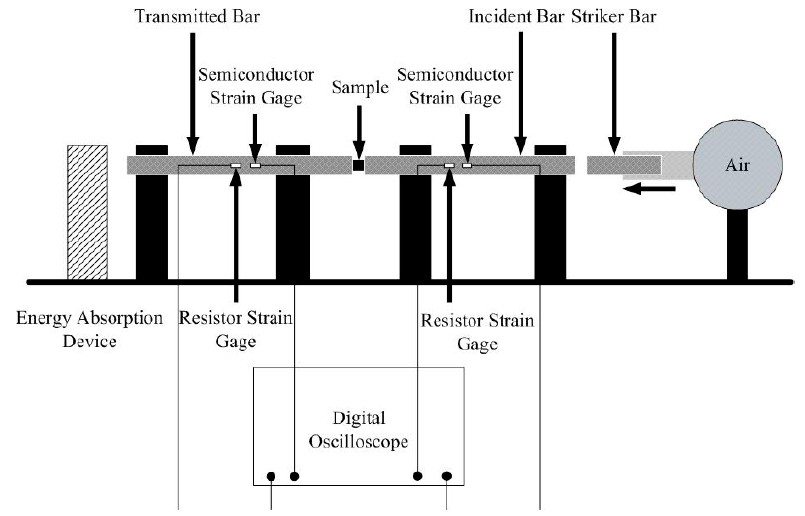
Figure 2. Schematic illustration of the SHPB system.